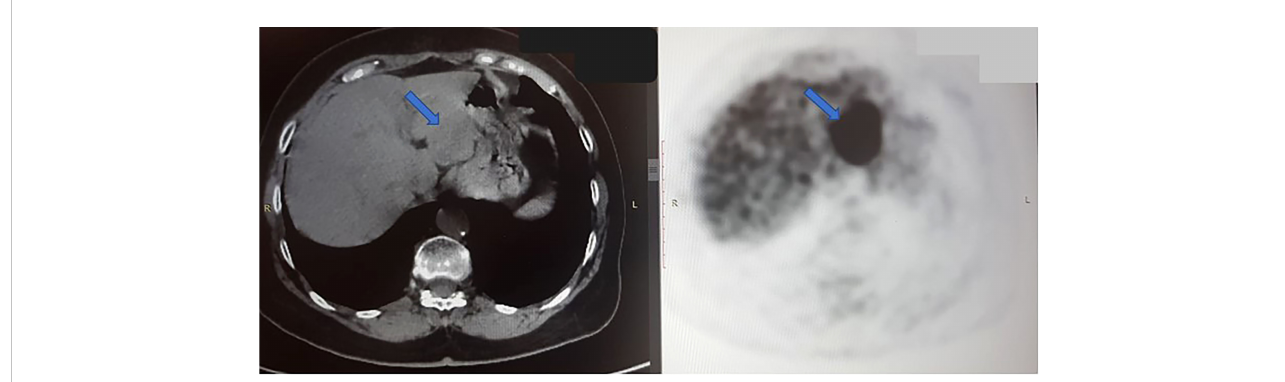
FIGURE 2 Axial CT scan (left) and PET scan (right) from October 2020, shows a large tumor in the left hepatic lobe (blue arrow). In PET scan, the dark mass shows an FDG-avid, metabolically active tumor. The right hepatic lobe is normal, without signs of malignancy at this